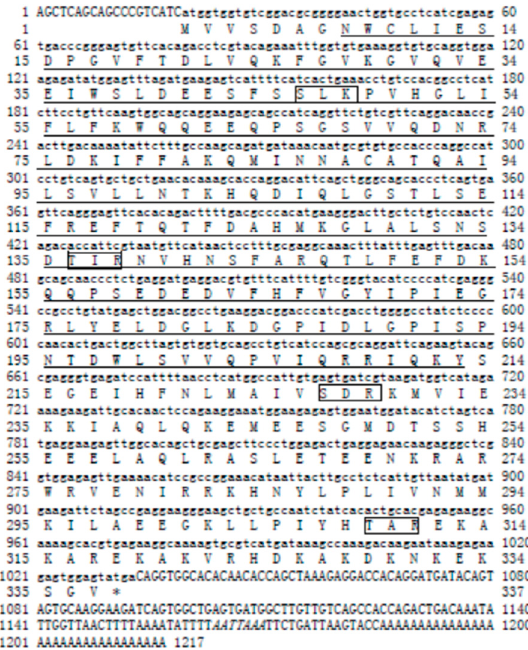
Figure 2. cDNA sequence and deduced amino acid sequence of Sp-uchl5. The capital bases represent the non-coding region, the small bases represent the open reading frame. The conserved sequence of the UCHL1 family is underlined, the 4 phosphorylation sites of protein kinase C are indicated in the box, and the polyadenylation signal (AATTAAA) is enclosed by italics.